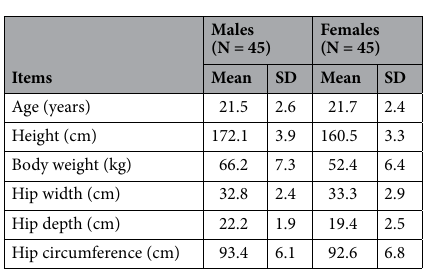
Table 1. Anthropometric data of the male and female